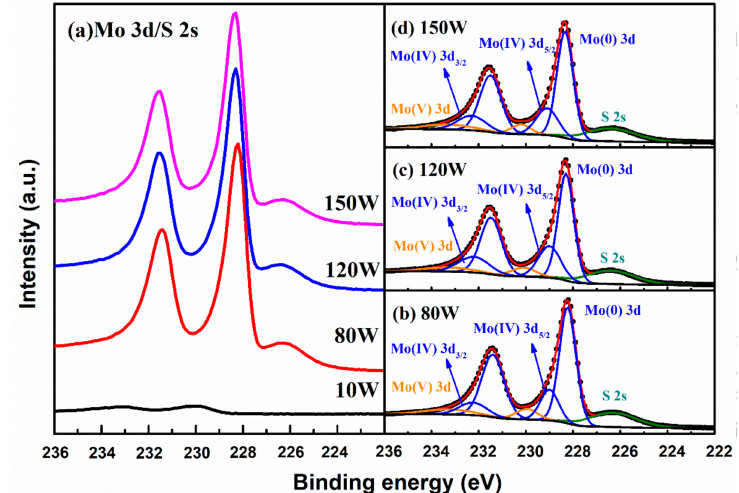
Figure 6. High-resolution X-ray photoelectron spectroscopy (XPS) spectra of ( a ) Mo 3d/S 2s, and ( b ), ( c ), and ( d ) Mo3d core-level spectra for an RF power of 80 W, 120 W, and 150 W, respectively. The background is shown with a black line at the bottom. The black dots represent the raw data. The red line is the total least-squares fit. The orange lines indicate the Mo(V) 3d components. The blue lines are the Mo3d components linked to Mo (0) and Mo (IV), the Mo (0) are the lower BE doublet. The olive lines are the S2s components. (See text for more